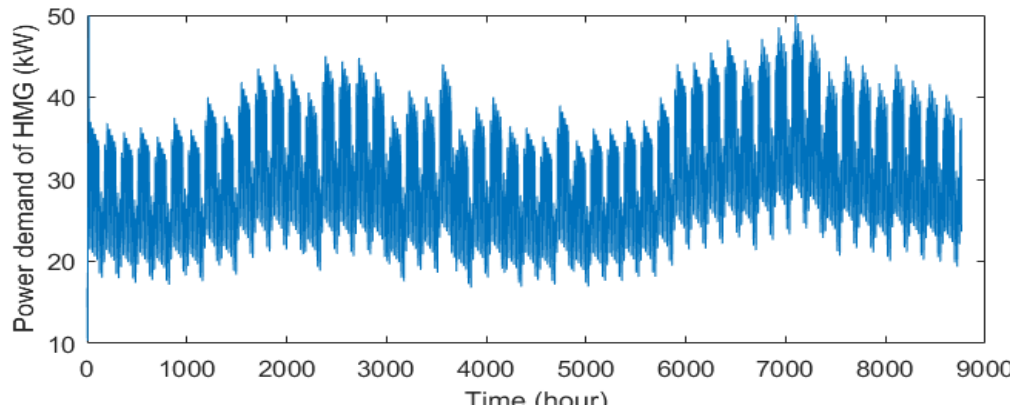
Figure 17. Profile of annual hybrid system demand.